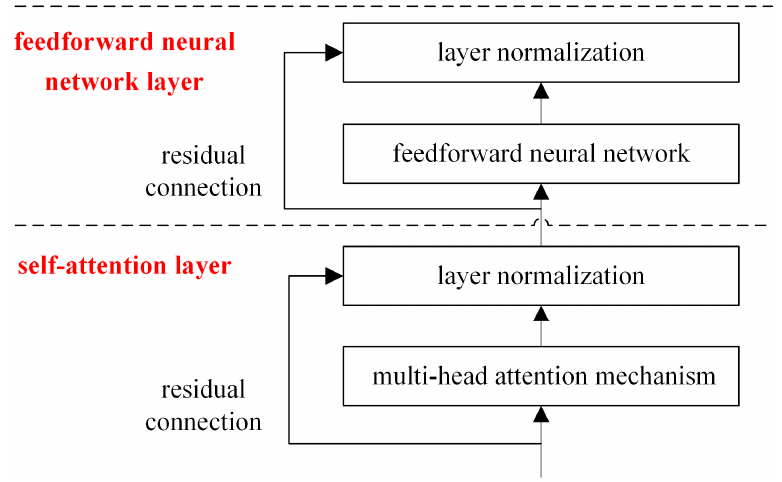
Figure 1. Structure of the a priori attention model.